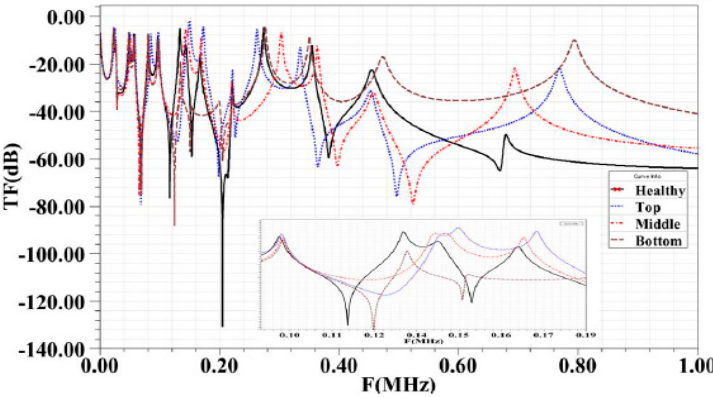
Figure 6. Impact of inter ‐ disk fault on the HV FRA signature [15].